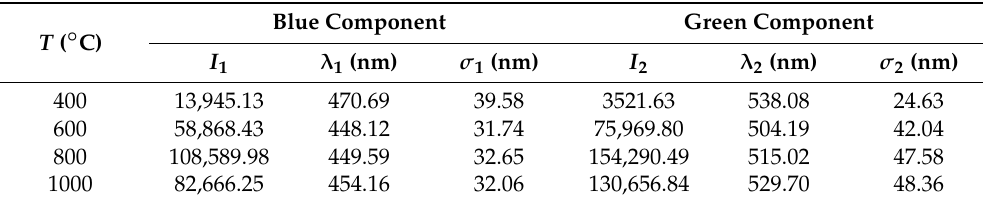
Table 2. Parameters of two-component Gaussian decomposition of the PL spectra of Eu-doped ZnWO 4 precursors subjected to annealing at different